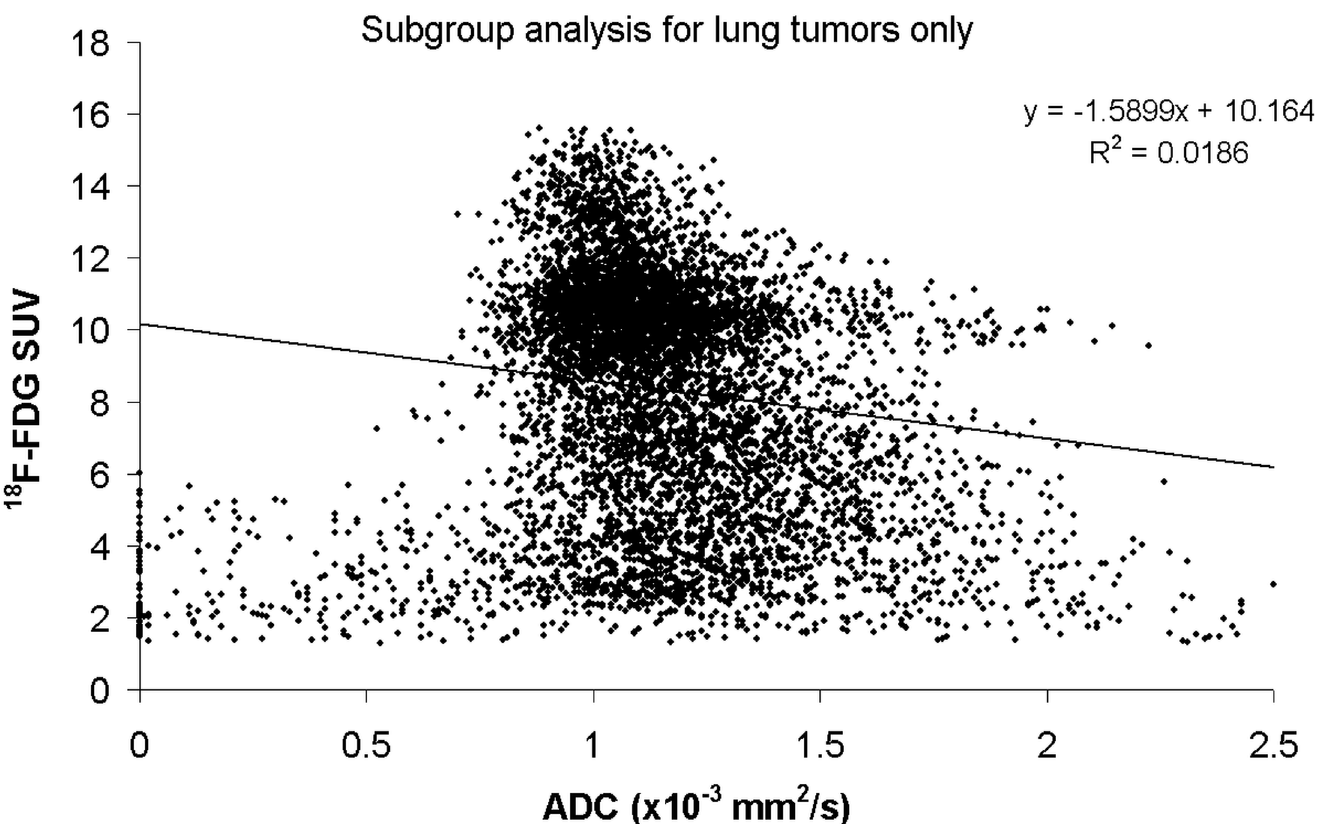
Fig 4. Subgroup analysis for the lung tumors only, showing a scatter plot of the voxel-by-voxel correlation of ADC and 18 F-FDG uptake. No correlation between the 18 F-FDG uptake and ADC can be demonstrated. The distribution of the voxel data is comparable to Fig 3 and 75% of the voxels are located in the SUVhigh/ADClow